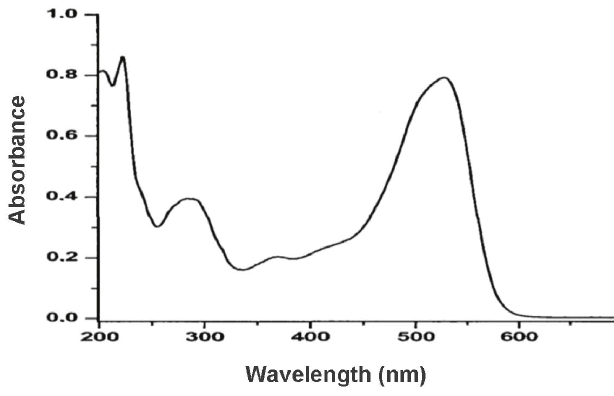
Fig. 1 – Absorption spectrum of SR 3BL